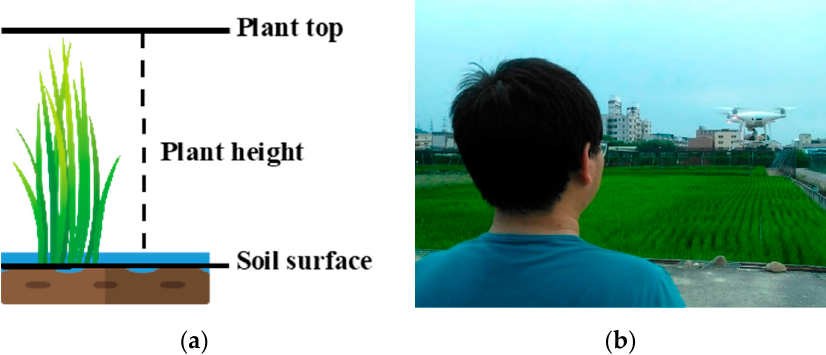
Figure 3. Overview of field plant height survey. ( a ) Plant height measured from soil surface to plant top using rulers; ( b ) Plant height generated by UAV.